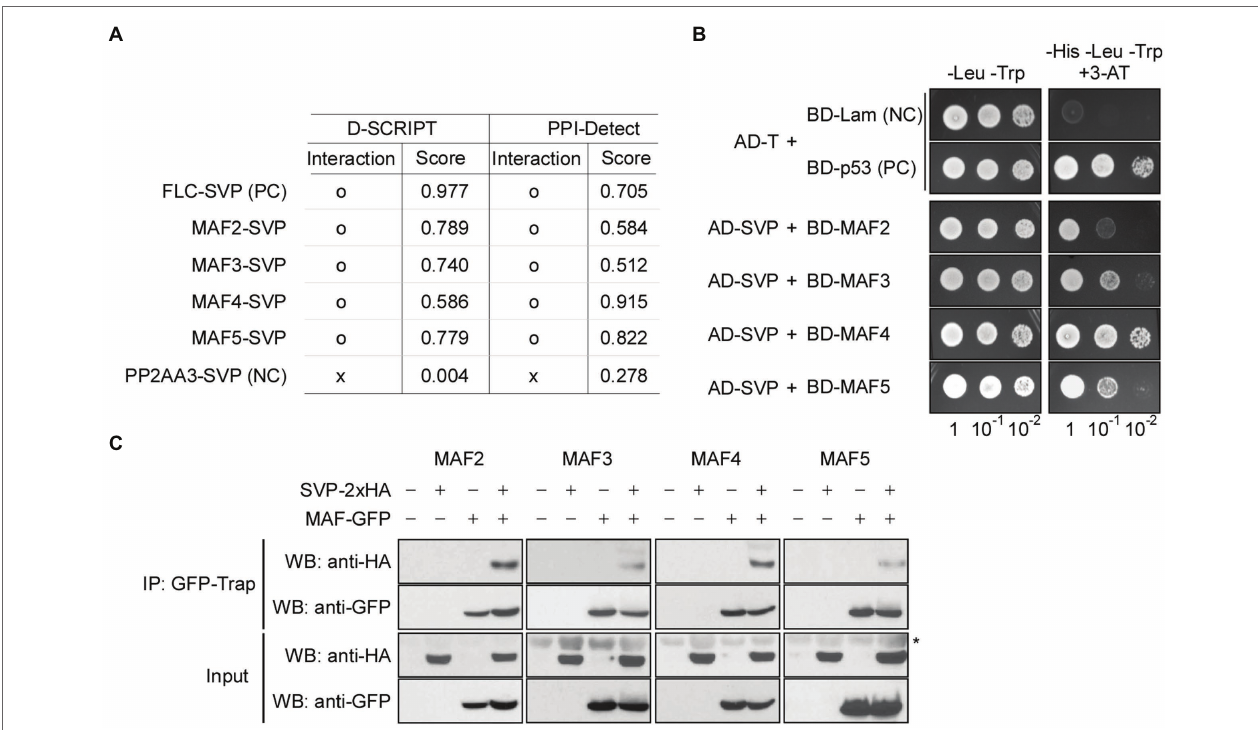
FIGURE 8 | MAFs physically interact with SVP. (A) Artificial intelligence (AI)–based prediction of interaction between MAFs and SVP. o: interaction, x: no interaction. Score (ranging from 0 to 1) represents the likelihood of interaction between two input proteins, where 0 represents no predicted interaction and 1 represents a high- confidence prediction that the proteins interact. (B) Yeast two-hybrid assays showing the interaction between MAFs and SVP. Positive control (PC): AD-T (SV40 large T-antigen) and BD-p53 (murine p53); negative control (NC): AD-T and BD-Lam (Lamin). (C) In vivo confirmation of MAF–SVP interactions via co- immunoprecipitation assays using Arabidopsis protoplasts at 10 ° C. PC; positive control, NC; negative control. The asterisk (*) represents a nonspecific signal on the anti-HA